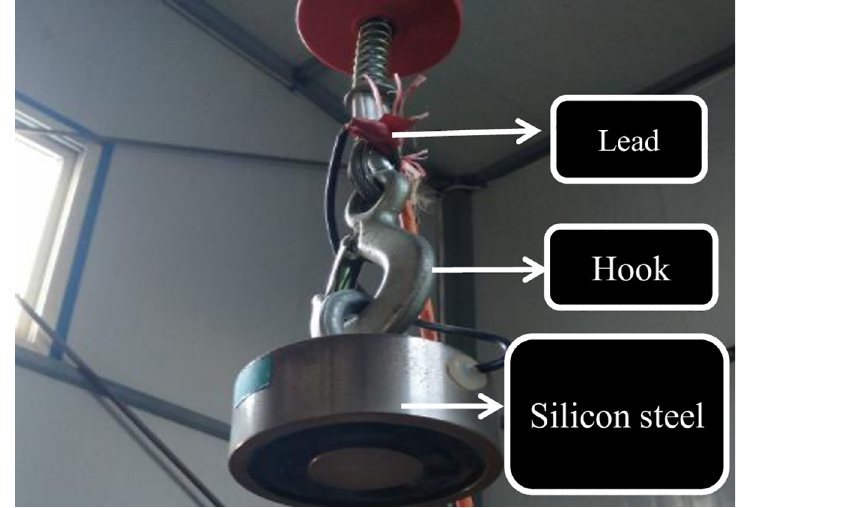
Fig 3. Electromagnetic self-weight decoupling